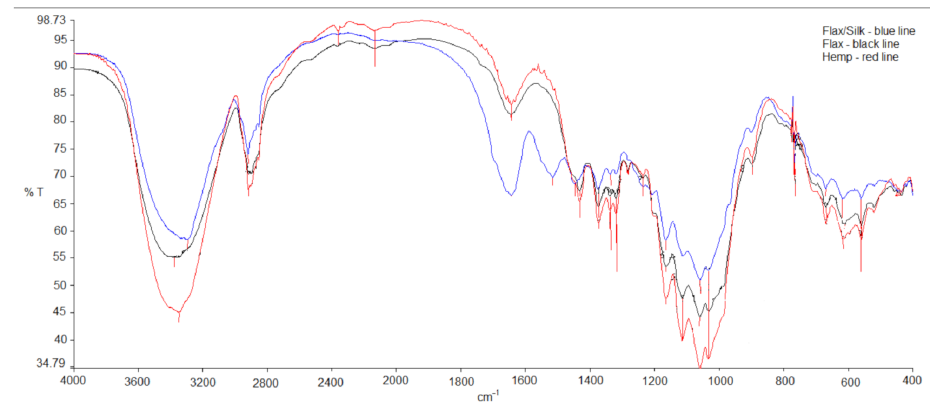
Figure 5. FTIR spectra of dyed bast